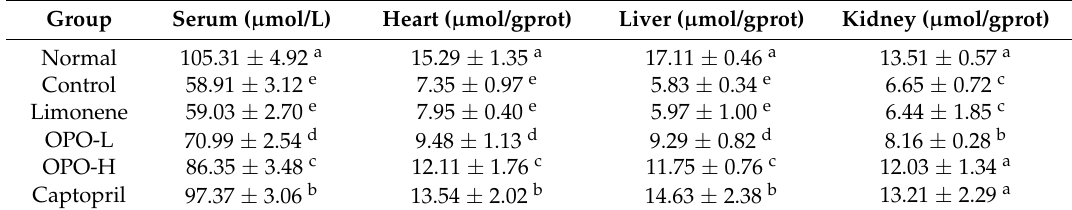
Table 3. Nitric oxide (NO) contents in serum, heart, liver and kidney of L -NNA-induced hypertensive rats. Group